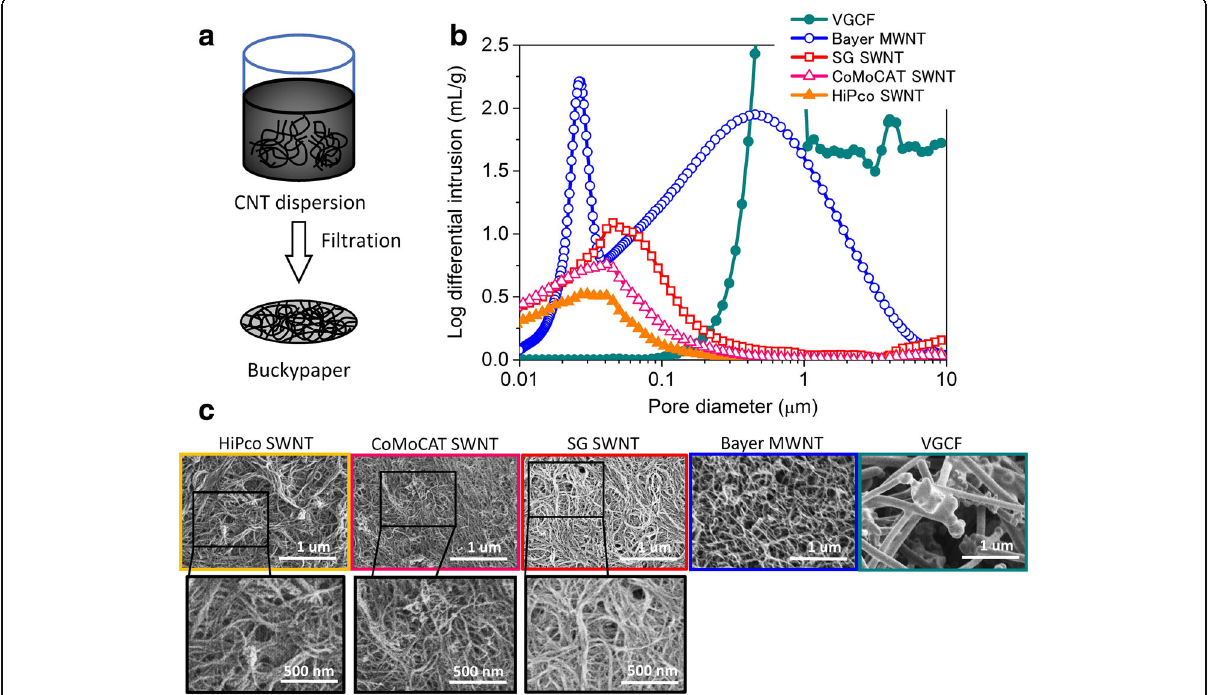
Fig. 1 Comparison of pores for various CNTs ’ Buckypapers by porosimeter. a Schematic for making a Buckypaper, b their pore volume (intruded mercury amount) distribution as a function of pore diameter, and c SEM images of the various CNTs ’ network structures spin-coated on flat surfaces, showing the broadened pore size distribution and increases in the pore volume with increasing CNT diameter (SWNTs to